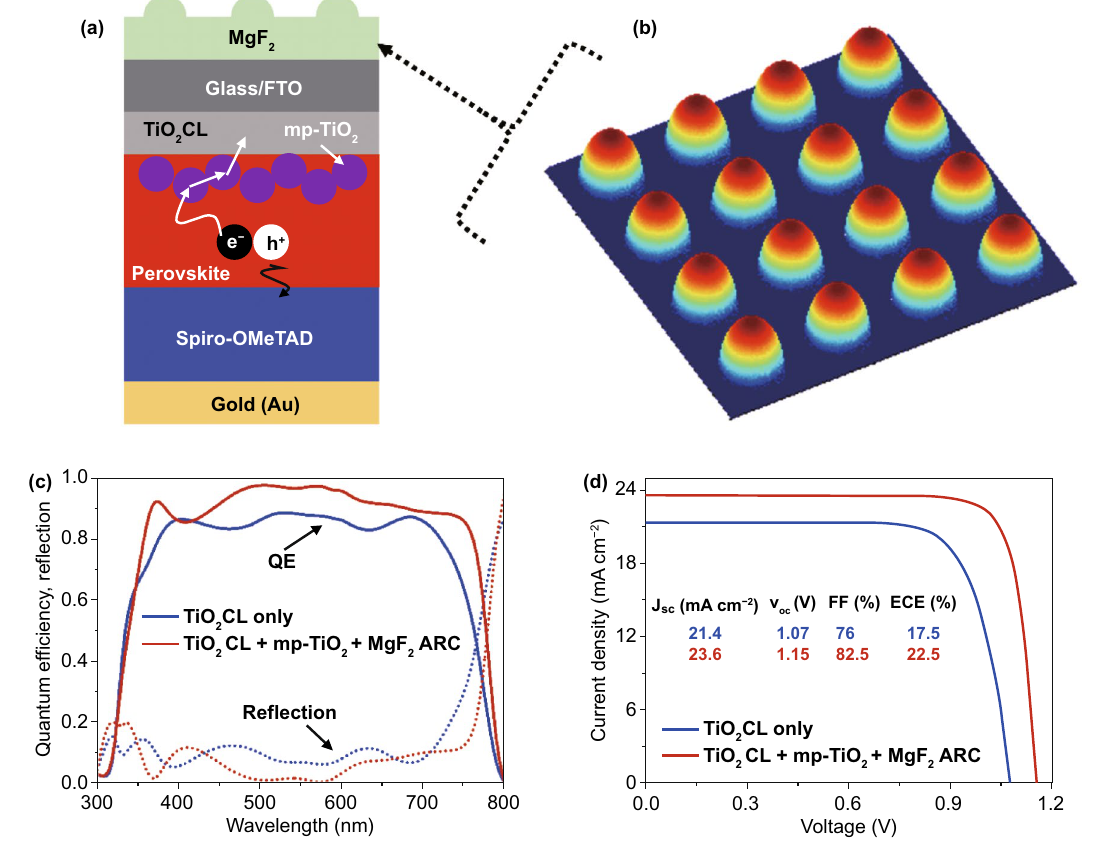
Fig. 4 a Schematic diagram of the optimized single‑junction perovskite solar cell. b Graphical representation of the nanostructured MgF 2 ARC layer. A comparison of c quantum efficiencies and corresponding reflections, and d J-V characteristic curves between optimized PSC (MgF 2 ARC/FTO/TiO 2 /mp‑TiO 2 /MAPbI 3 /Spiro/Au) and planar reference PSC (FTO/TiO 2 /MAPbI 3